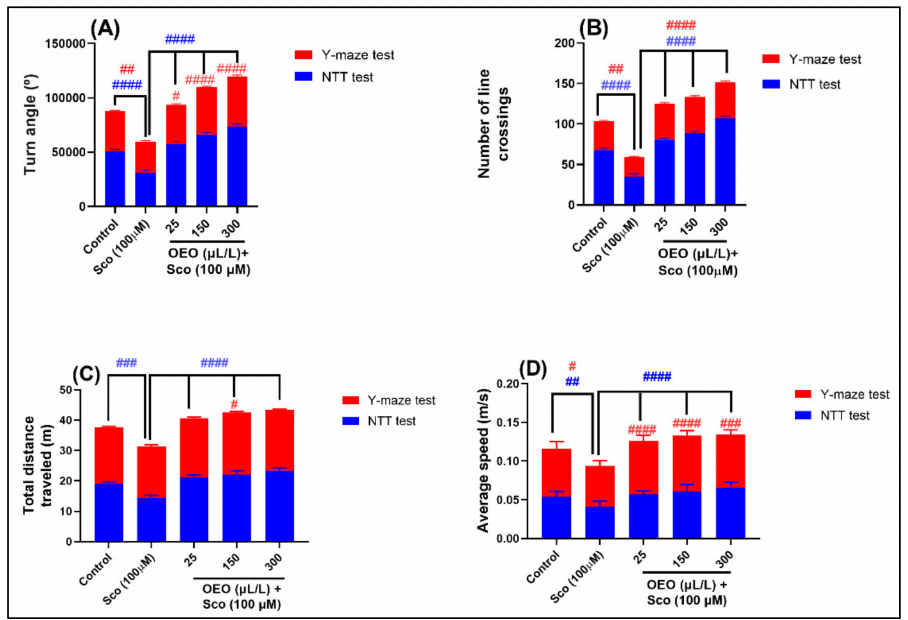
Figure 4. Comparative analyses of zebrafish anxiety-like behavior and spatial memory for the control, Sco (100 µ M) and OEO (25, 150, 300 µ L/L) group treatment, based on locomotion parameters for the novel tank diving test (NTT) vs. the Y-maze test. ( A ). Turn angle ( ◦ ); ( B ). Number of line crossings; ( C ). Total distance traveled (m); ( D ). Average speed (m/s). Values are means ± S.E.M. ( n = 10). For Tukey’s post hoc analyses: # p < 0.01, ## p < 0.001, ### p < 0.0001, and #### p < 0.00001.